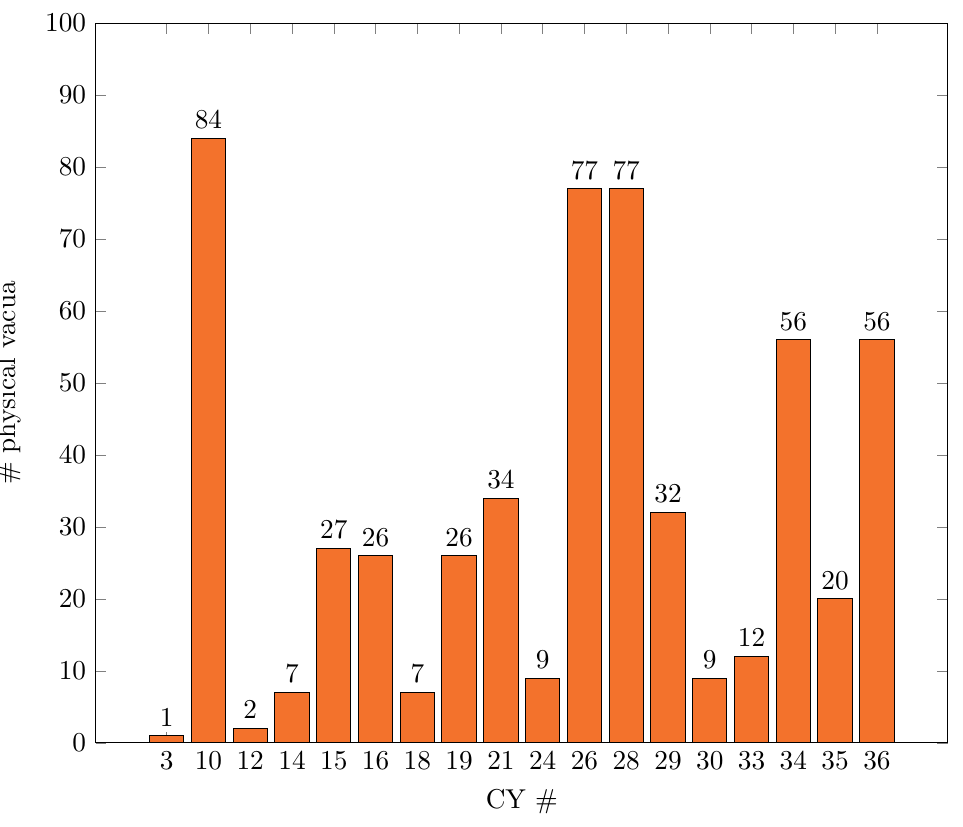
Figure 3. PFFV configurations with physical vacua for all the 18 pCICY